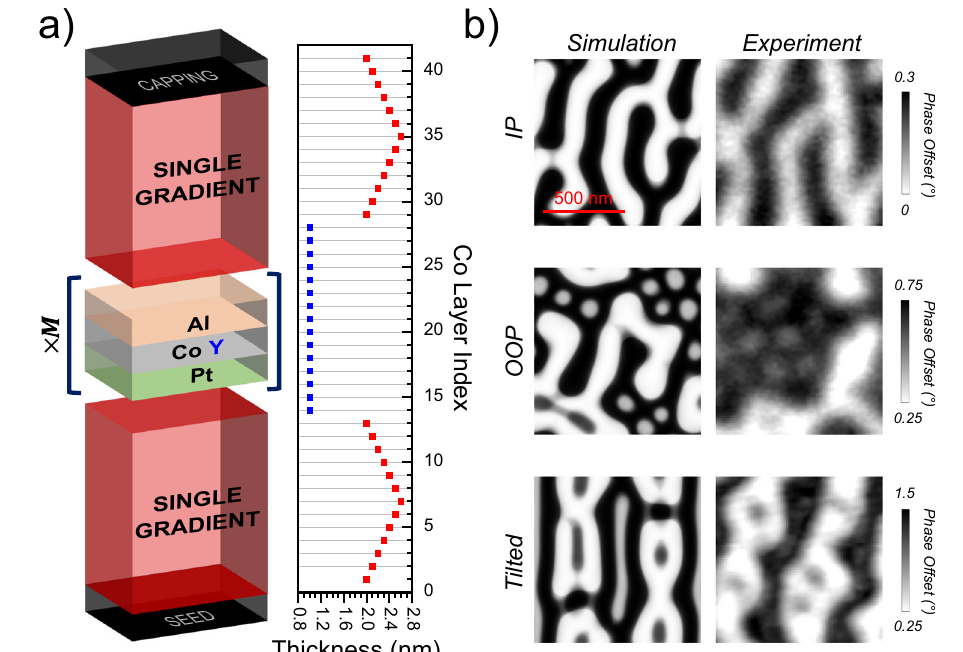
Fig. 2 | Remanent magnetic con fi guration in DG multilayer with parameters S =0.1nm, Y =1.0nm, N =13 layers, M =15 repetitions. a Schematic X 1 =2.0nm, structure with additional parameters of the thin Co thickness Y and the associated number of repetitions M . The lateral plot shows the Co thickness evolution. b Simulatedandexperimentalphasemapsfordifferentmagnetichistories.Forthe